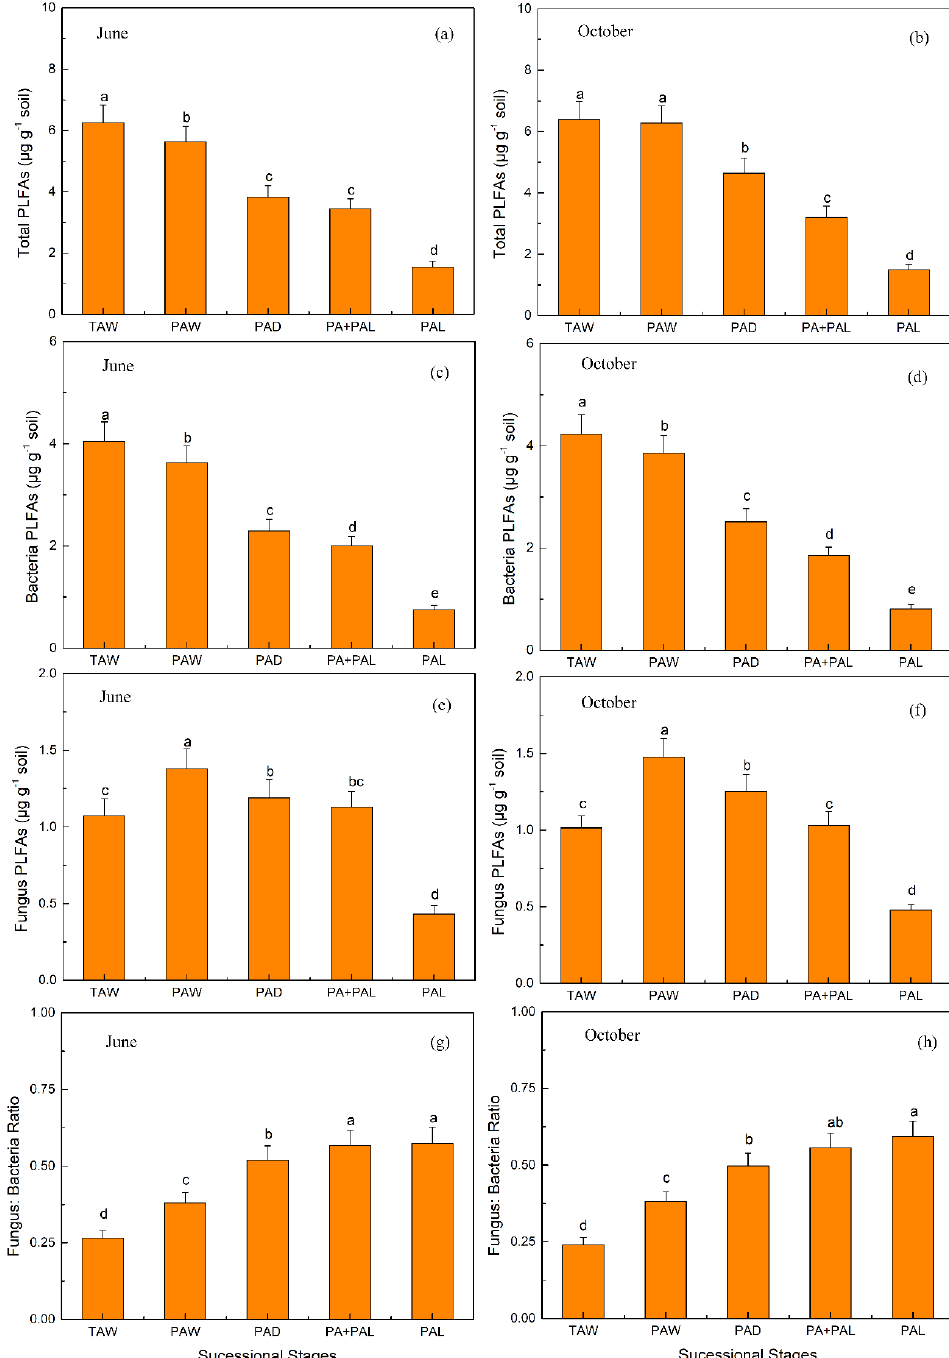
Figure 3. Microbial community structure of top soil (0–10 cm) derived from phospholipid fatty acid (PLFAs) analysis at di ff erent stages of wetland drying process in June ( a , c , e , g ) and October ( b , d , f , h ). Values are Mean ± SE ( n = 9). Di ff erent letters over the bars indicate statistically significant di ff erences between di ff erent stages. TAW, T. augustifolia wetland; PAW, P. australis wetland; PAD, P. australis dry land; PA + PAL, mixed grassland with P. australis and P. arundinacea L.; PAL, P. arundinacea L. grassland. Soil basal respiration and microbial metabolic quotient (qCO 2 ) of each stage in June and October − 1 − 1 are shown in Figure 4. Soil basal respiration ranged from 1.08 to 2.57 mg CO 2 kg soil h in June and − 1 − 1 range from 0.82 to 2.04 mg CO 2 kg soil h in October. Soil qCO 2 ranged from 12.1 to 25.4 mg CO 2 − 1 − 1 − 1 − 1 g h in June and ranged from 5.5 to 15.8 mg CO 2 g h in October. Soil basal respirations